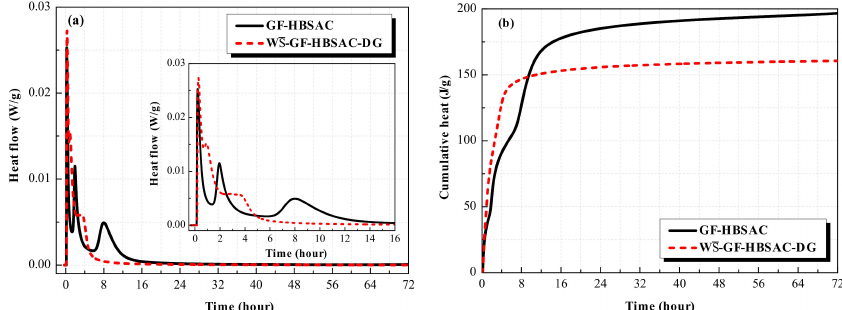
Figure 11. Hydration heat curves of the Series GF-HBSAC-X cement: ( a ) Heat flow curve; ( b ) cumulative heat curve.